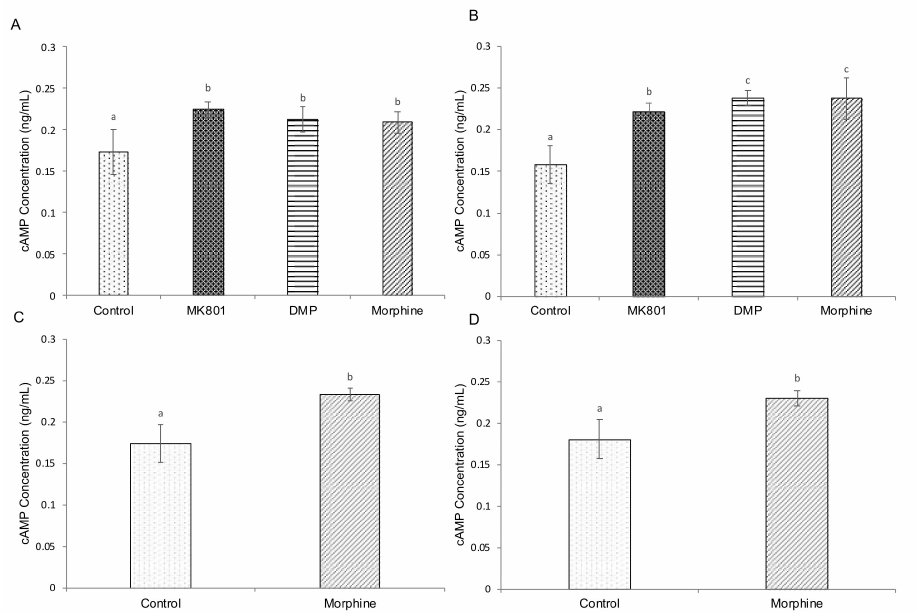
Figure 3. Effects of ( A ) short-term (F (3,32) = 22.035, p < 0.001) and ( B ) long-term (F (3,32) = 108.164, p < 0.001) exposure to MK801, DMP and morphine, and ( C ) short-term ( t (16) = 12.465, p = 0.003) ( D ) and long-term ( t (16) = 9.964, p = 0.029) morphine withdrawal on whole-body cAMP concentration (ng/mL) in zebrafish larvae. Data expressed as mean ± SEM, n = 50 of 3 independent experiments. Different lowercase letters indicate statistically significant values, p < 0.05. cAMP: cyclic adenosine monophosphate, DMP: domperidone.